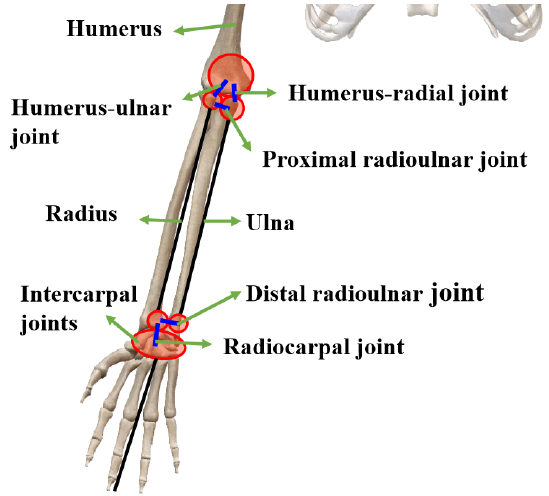
Figure 4. Anatomical structure of the elbow complex and the wrist joint.